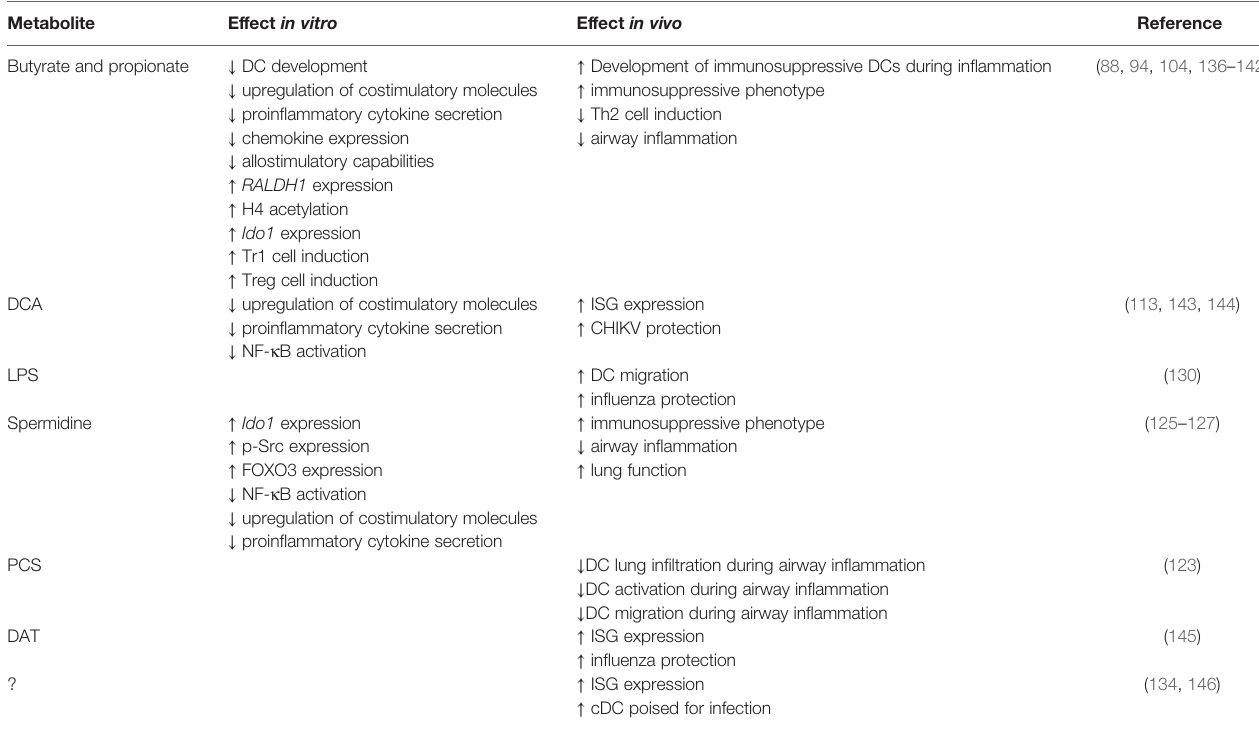
TABLE 1 | Microbial metabolites and their impact on DCs in vitro and in